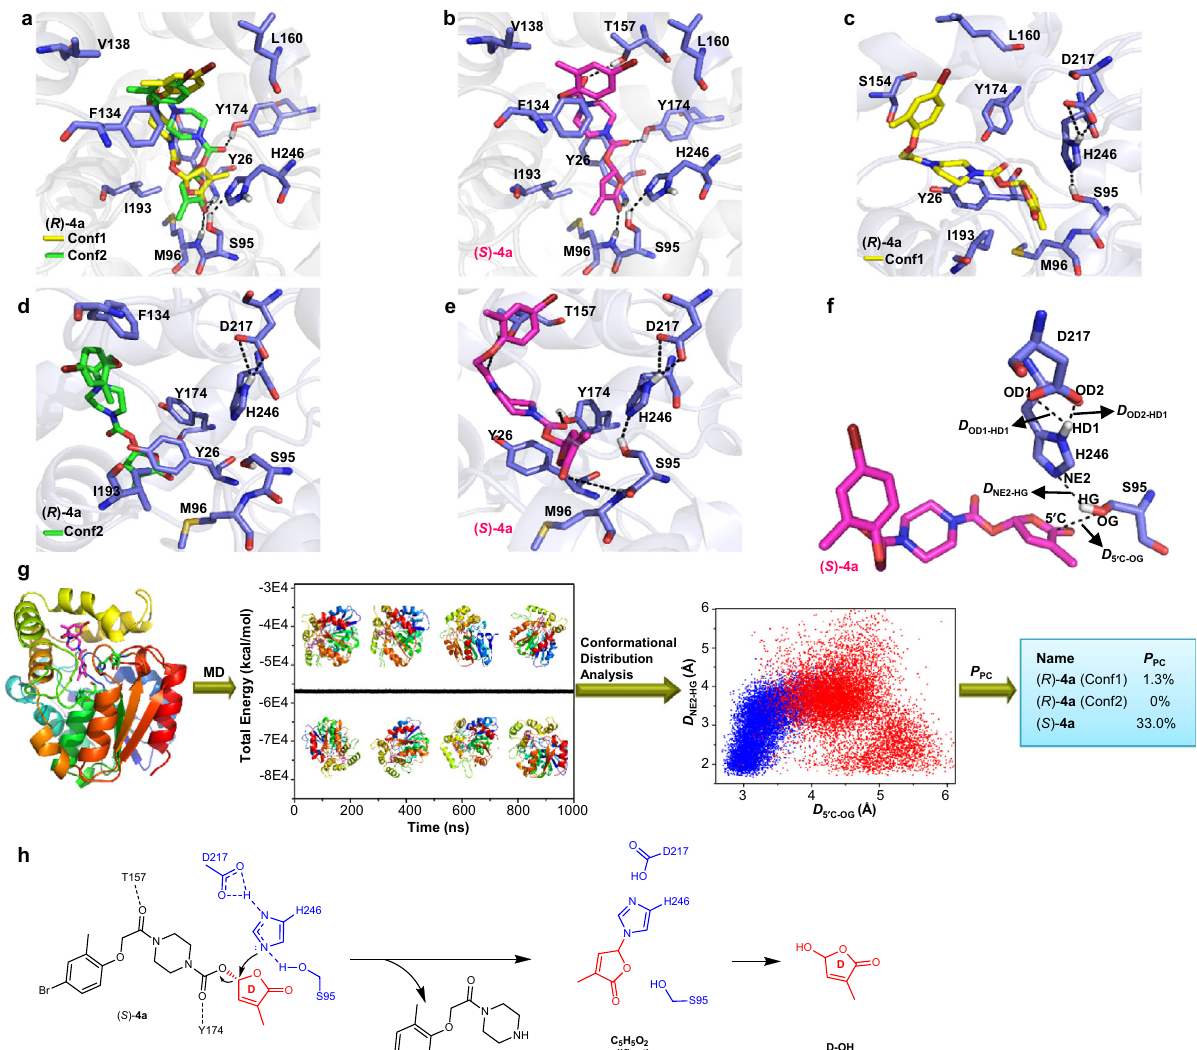
Fig. 5 Molecular simulations of compounds ( R )- and ( S )-4a with ShHTL7. The key residues around the binding pocket are shown as blue sticks and the hydrogen-bonding interactions are shown as black dashed lines. a Docking models of ( R )- 4a to ShHTL7, there were two reasonable binding modes: Conf1 (shown in yellow stick) and Conf2 (shown as green stick). b Docking model of ( S )- 4a to ShHTL7, ( S )- 4a is shown as magentas sticks. c – e Binding models of ( R )- 4a (conf1), ( R )- 4a (conf2), and ( S )- 4a to ShHTL7, respectively. The models were taken from the last frame of each simulation at 1000ns. f A schematic description of the hydrolysis reaction of the catalytic triad. D 5 ′ C-OG , D NE2-HG , D OD1-HD1 , and D OD2-HD1 were used as a set of geometry parameters to describe the privileged conformation (PC) of ligands and ShHTL7. g A process to predict the privileged conformation of ( R )- and ( S )- 4a with ShHL7 based on the MD simulations and conformational distribution statistical analysis. h A proposed alternative schematic diagram of the ShHTL7-mediated ( S )- 4a hydrolysis pathway. The hydrogen-bonding interactions of Thr157 and 2O atom, and Tyr174 and 3O atom could activate the leaving group, and the catalytic process begins with the nucleophilic attack by the NE2 atom of His246 to the 2 ′ C atom of ( S )- 4a , which results in the C 5 H 5 O 2 modi fi cation of